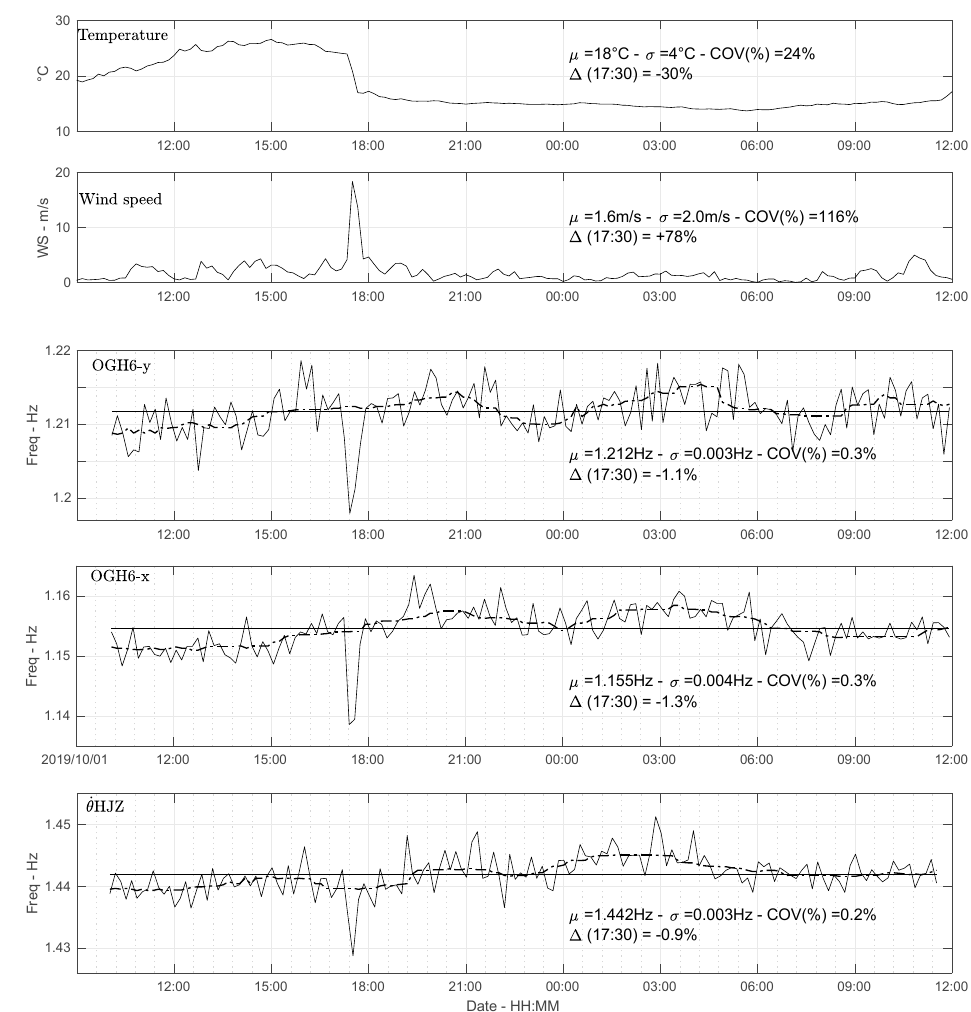
Figure 6. Time variation of weather conditions (temperature and wind velocity) and resonance frequencies in translation in directions x and y (station OGH6), and in rotation obtained by the rotation sensor HJZ.